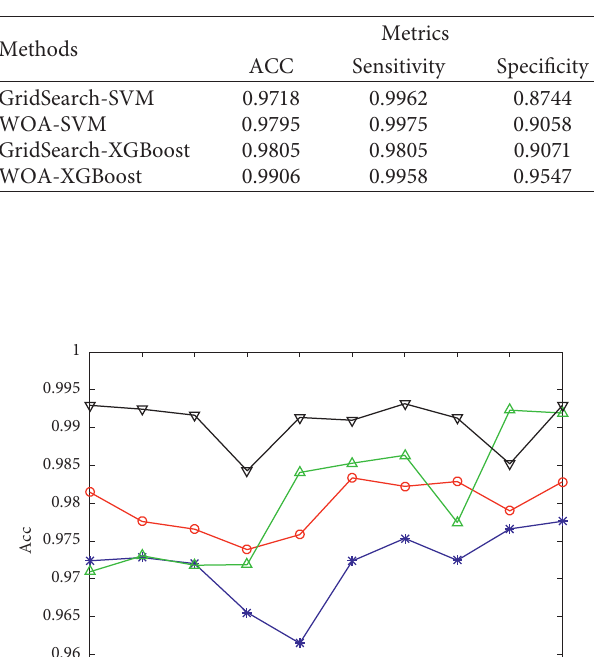
Table 5: Detail results without feature selection.